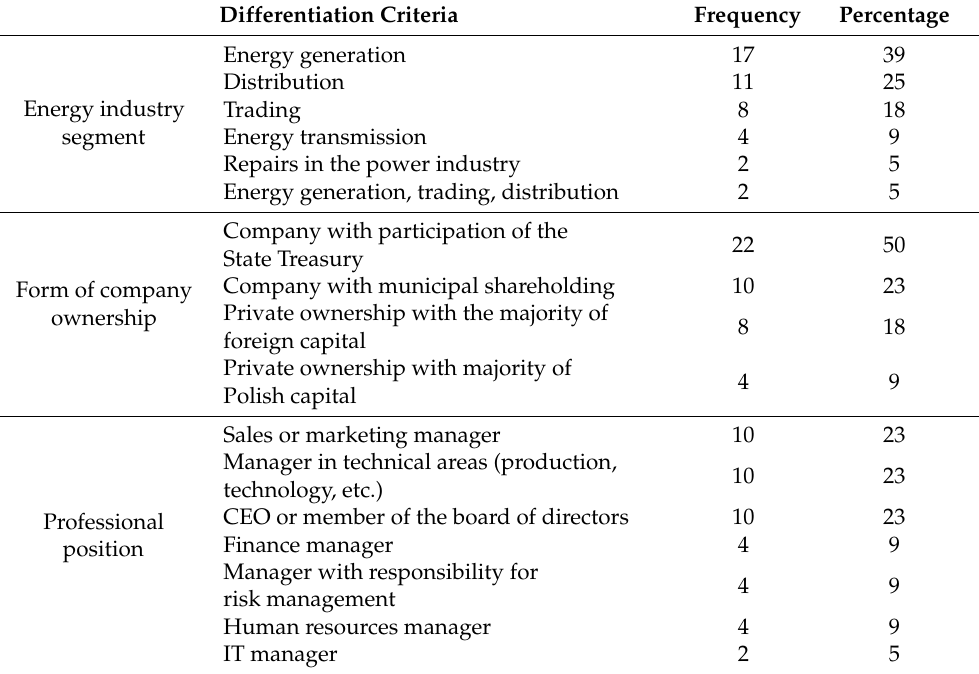
Table 2. Characteristics of the research